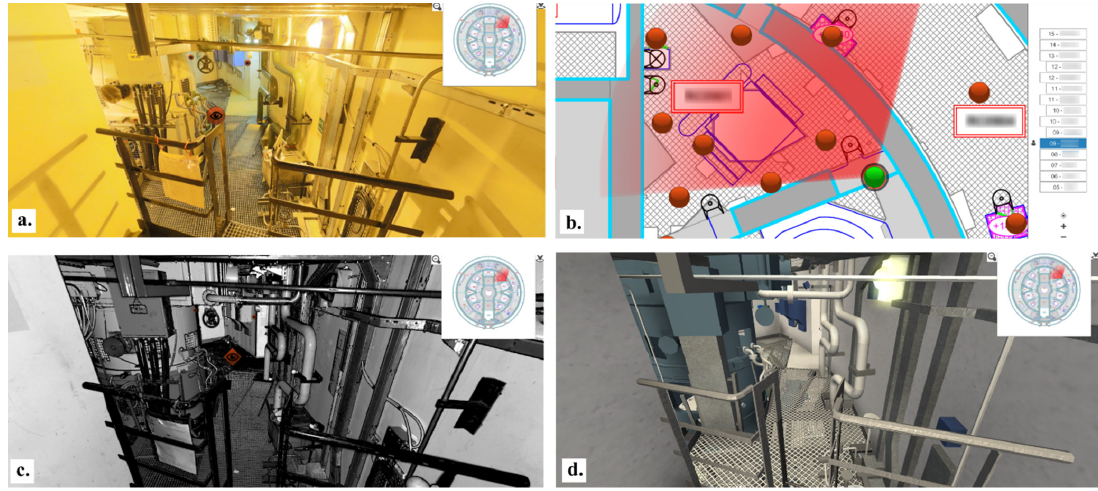
Figure 15. Multi-source data exploration and navigation in a complex building: visualization and station-based transitions of ( a ) panoramic images and ( b ) laser scans; ( c ) 2D map view of all stations and synchronized mini-maps and ( d ) first-person pedestrian navigation in the 3D model, including climbing ladders, taking stairs and crouching.